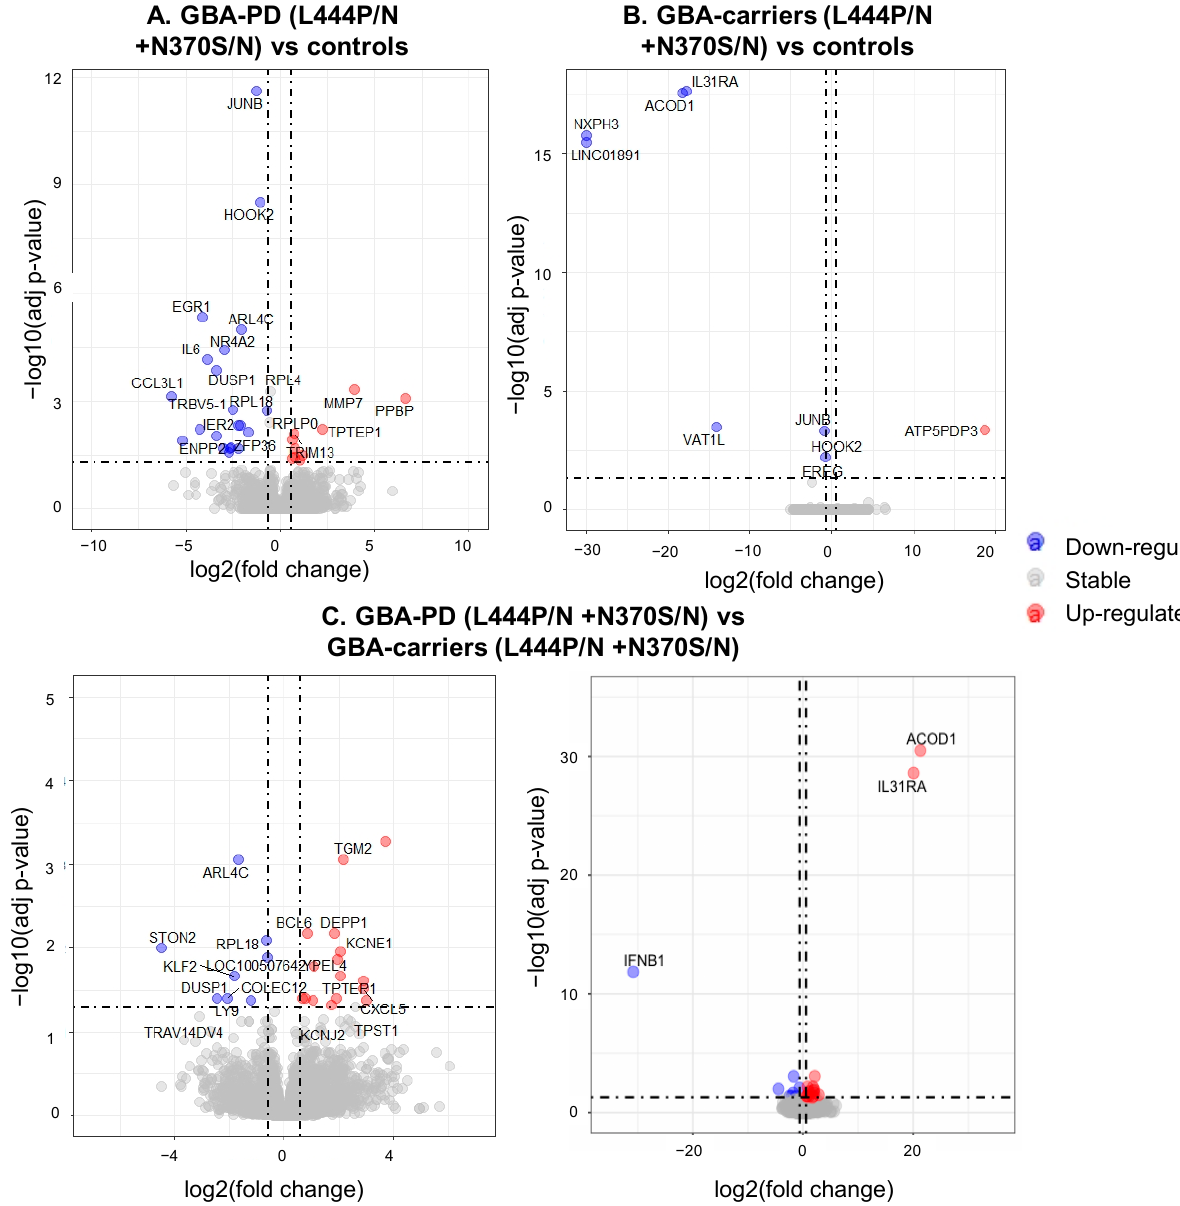
Figure 4. Volcano plot for DEGs between the studied groups (FDR < 0.05 and |FC| > 1.5); the upregulated genes are represented by red dots and the downregulated genes are represented by blue dots. ( A ). GBA-PD patients and controls; ( B ). GBA carriers and controls; ( C ). GBA-PD patients and GBA carriers. (GBA-PD—Parkinson’s disease associated with mutations in the GBA gene; GBA carriers—asymptomatic GBA mutation carriers; DEGs—differentially expressed genes).